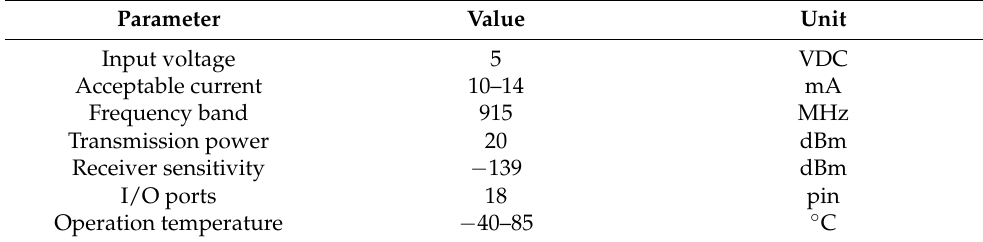
Figure 6. The configuration of TTGO LoRa32 V2.0 module for proposed PV junction box monitoring system. Table 1. Specification of TTGO LoRa32 V2.0